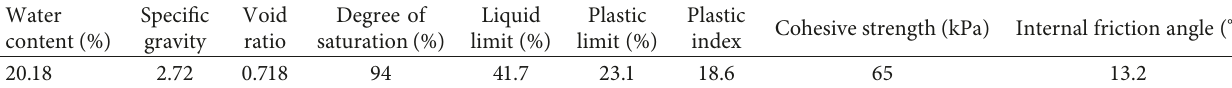
Table 1: Basic physical properties of the tested soil.